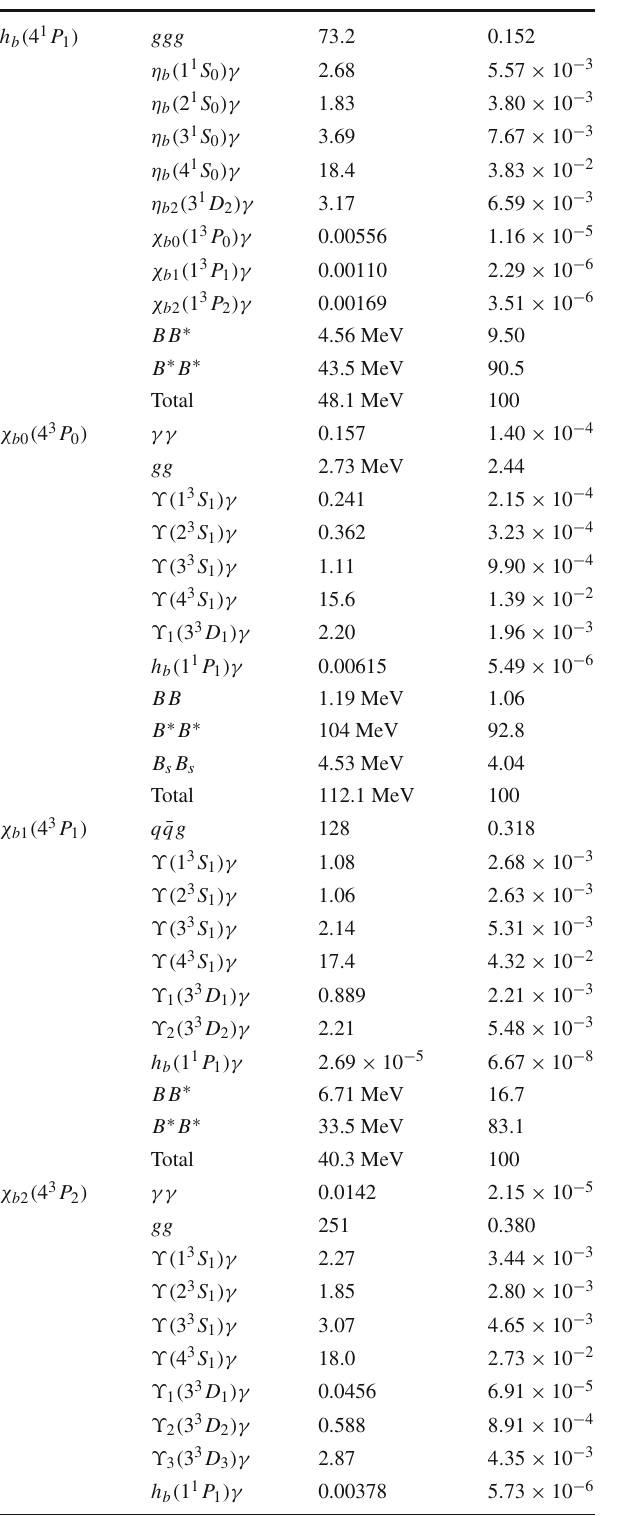
Table22 PartialwidthsandbranchingratiosoftheOZI-allowedstrong decay, annihilation decay, and radiative transition and the total widths for the 4 P bottomonium states. The width results are in units of keV